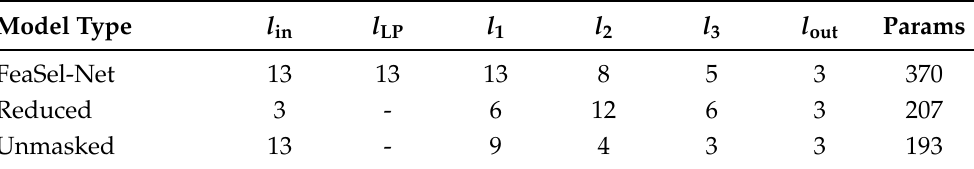
Table A3. Different model architectures used for the Wine Classification dataset. The table shows the number of nodes in each layer and the number of parameters.